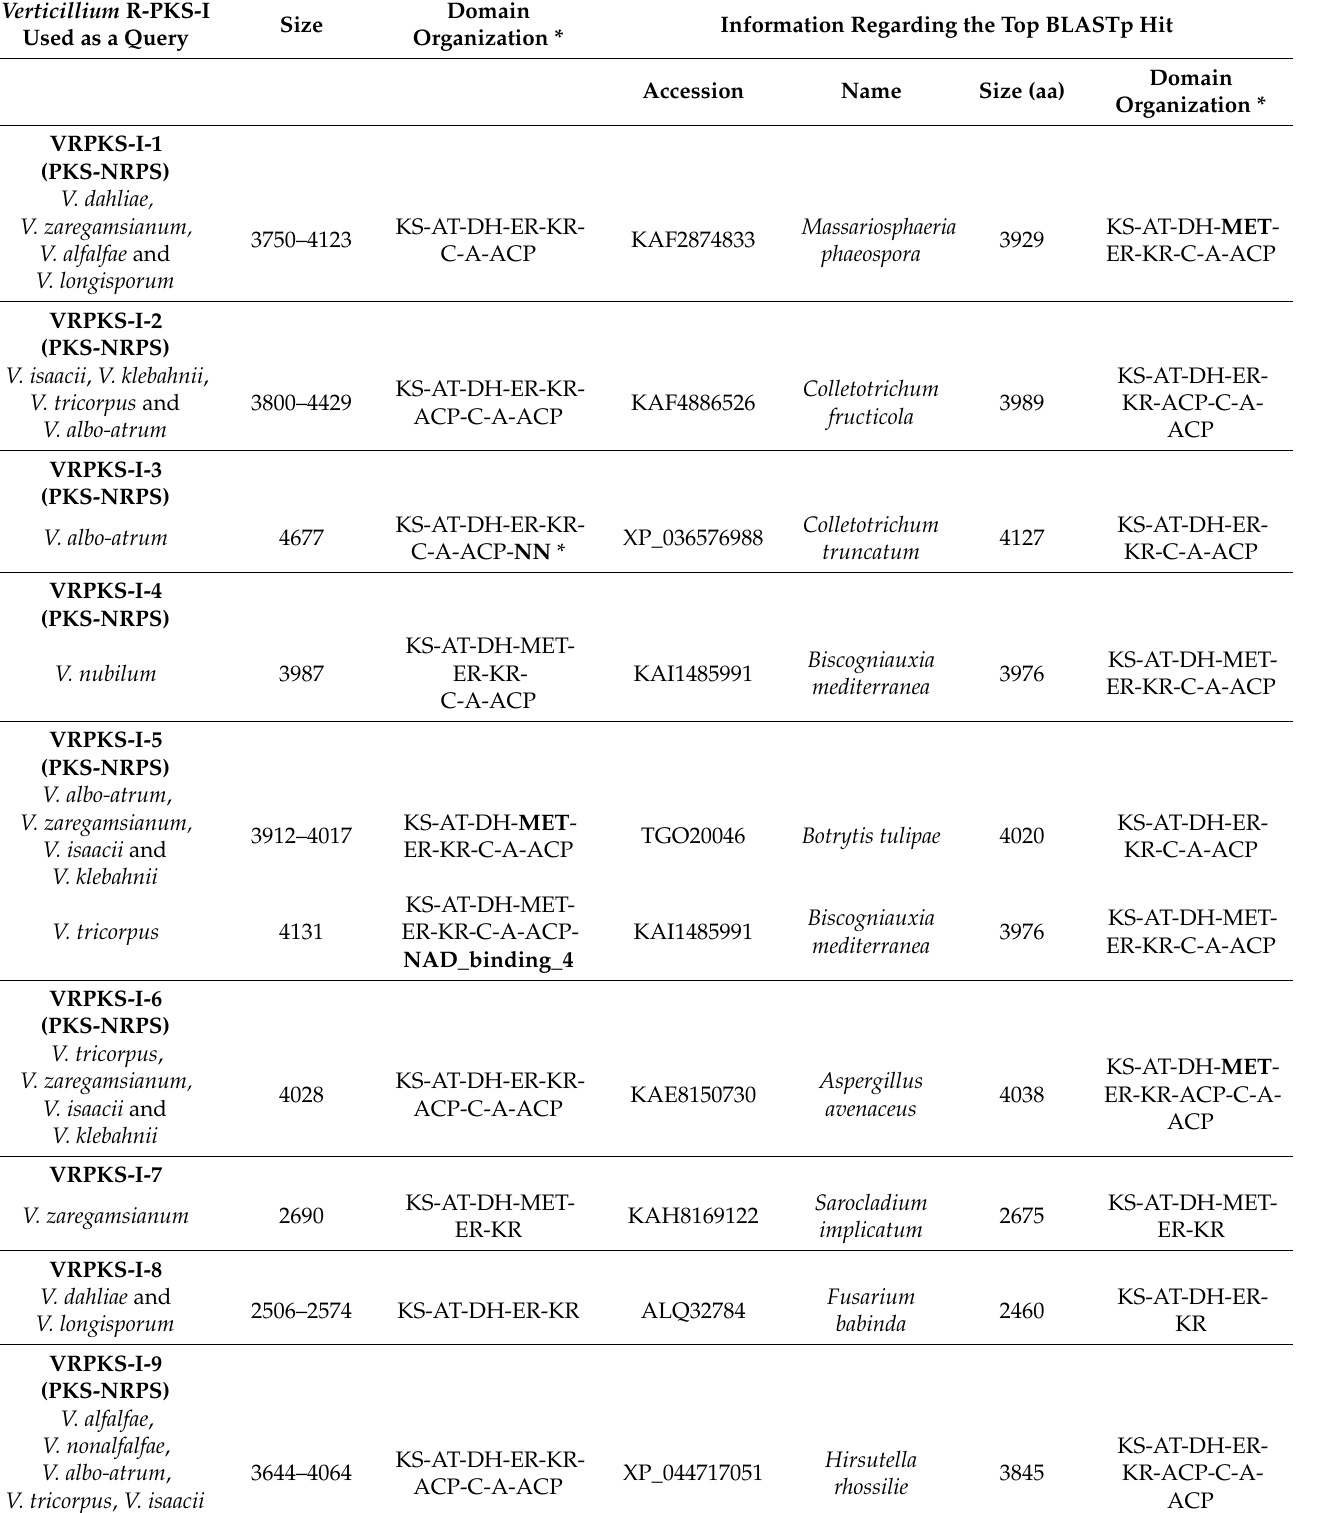
Table 3. Comparison of the size and domain structure of the Verticillium R-PKS-I proteins with top BLASTp hits in the NCBI